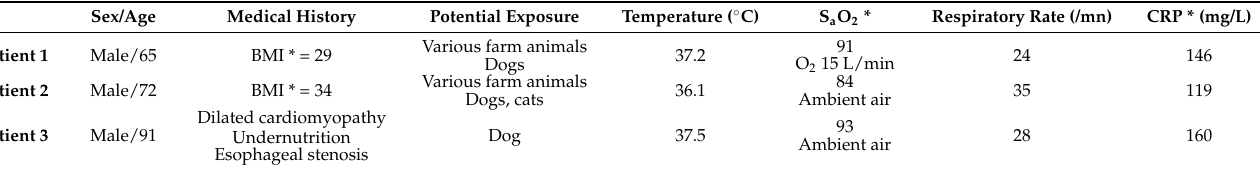
Table 1. Patients’ characteristics at admission.